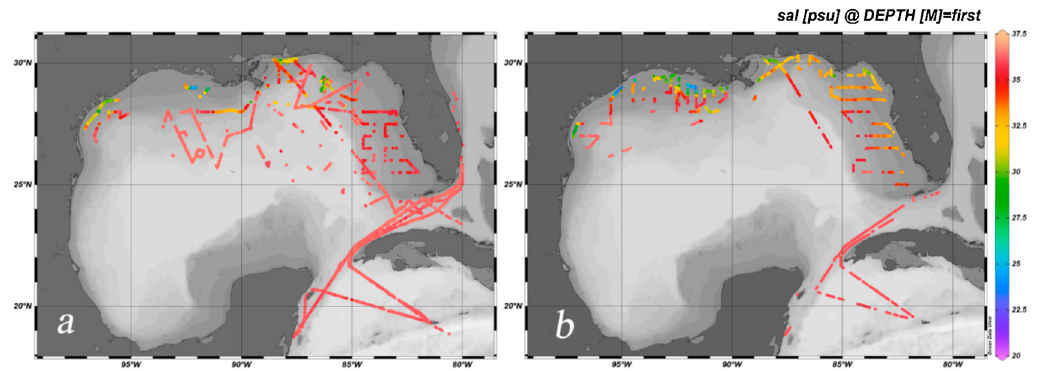
Figure 2. ( a ) Spatial distribution of conjugate samples of remote sensing and in-situ data in the GOM for SSS model development and validation; ( b ) spatial distribution of conjugate samples for model independent validation.